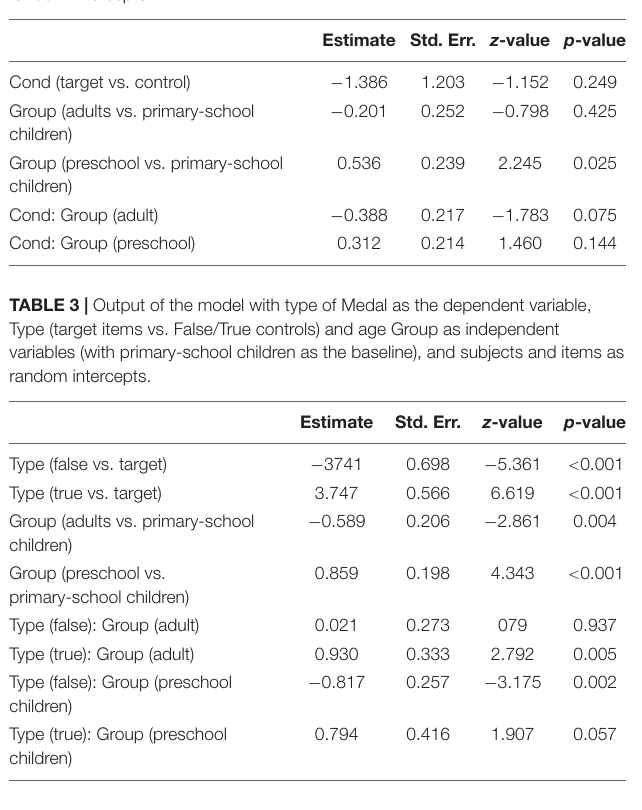
TABLE 2 | Output of the model with type of Medal as the dependent variable, Condition and age Group as independent variables (dummy coded with control and primary-school children as baselines), and subjects and items as random intercepts.